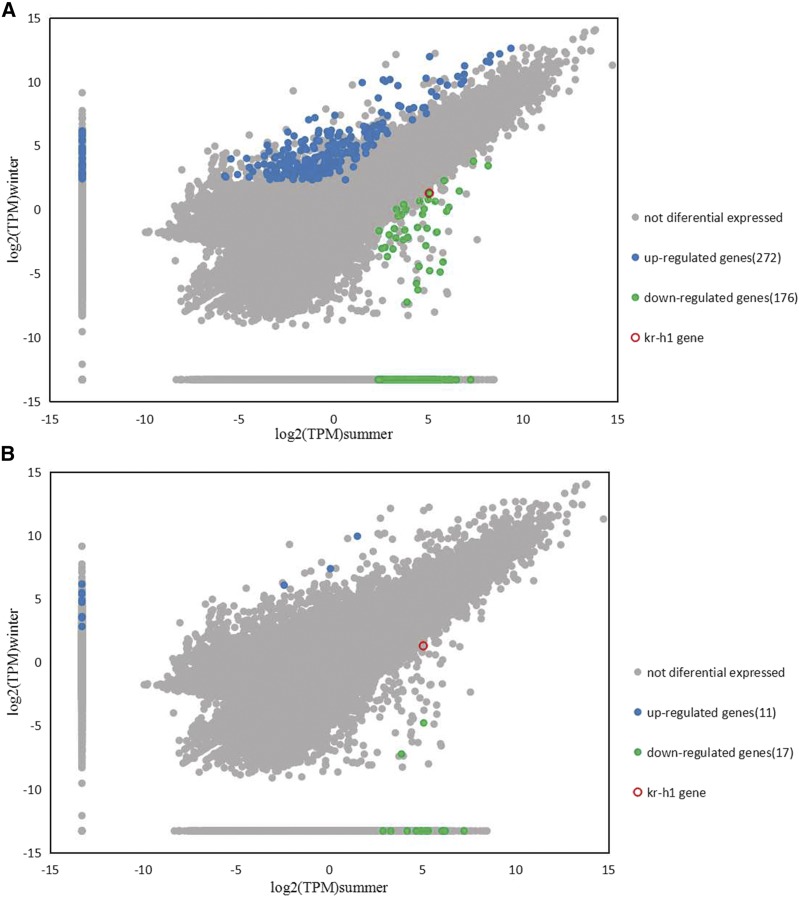
Expression profile of unigenes in two groups The x-axis represents log2(TPM)summer. The y-axis represents log2(TPM)winter. (A) Differentially expressed genes with P ≤ 0.05 before multiple tests. (B) Differentially expressed genes with corrected P ≤ 0.05 after multiple tests.